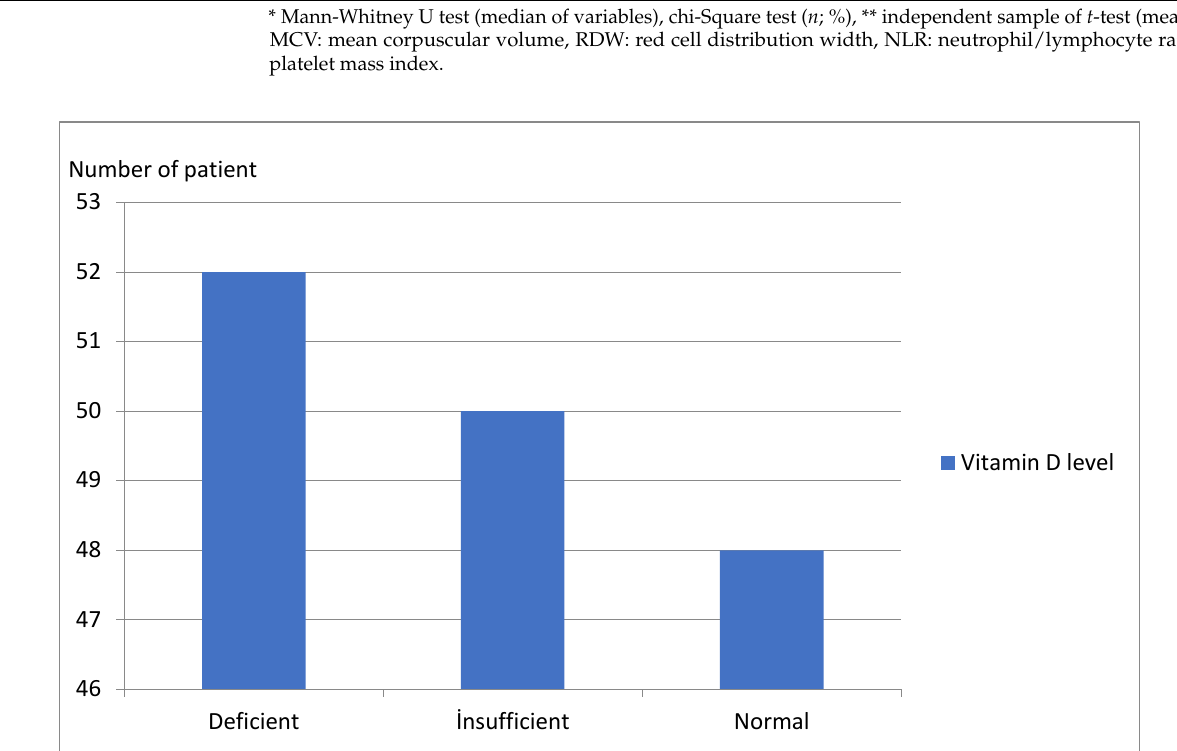
Figure 1: Number of patients by vitamin D levels. Figure 1. Number of patients by vitamin D Table 1. Sociodemographic and biochemical characteristics of the two samples .